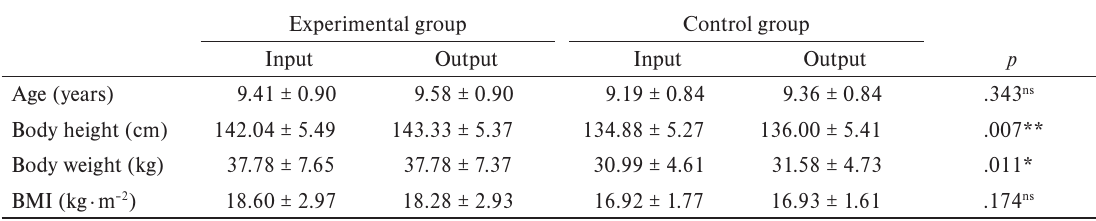
Basic age and somatic characteristics (M ± SD) of the groups at the beginning and at the end of the research Experimental group